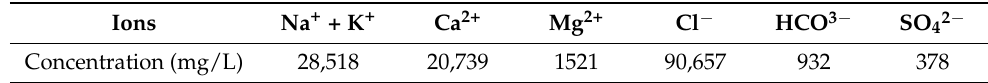
Table 2. Ionic fraction of extracted water media on